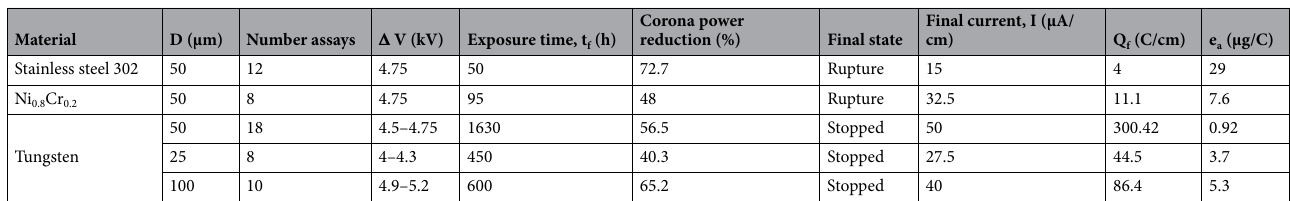
Table 2. Experimental considerations, materials, and average degradation rate of W, Ni 0,8 Cr 0,2 and stainless steel.